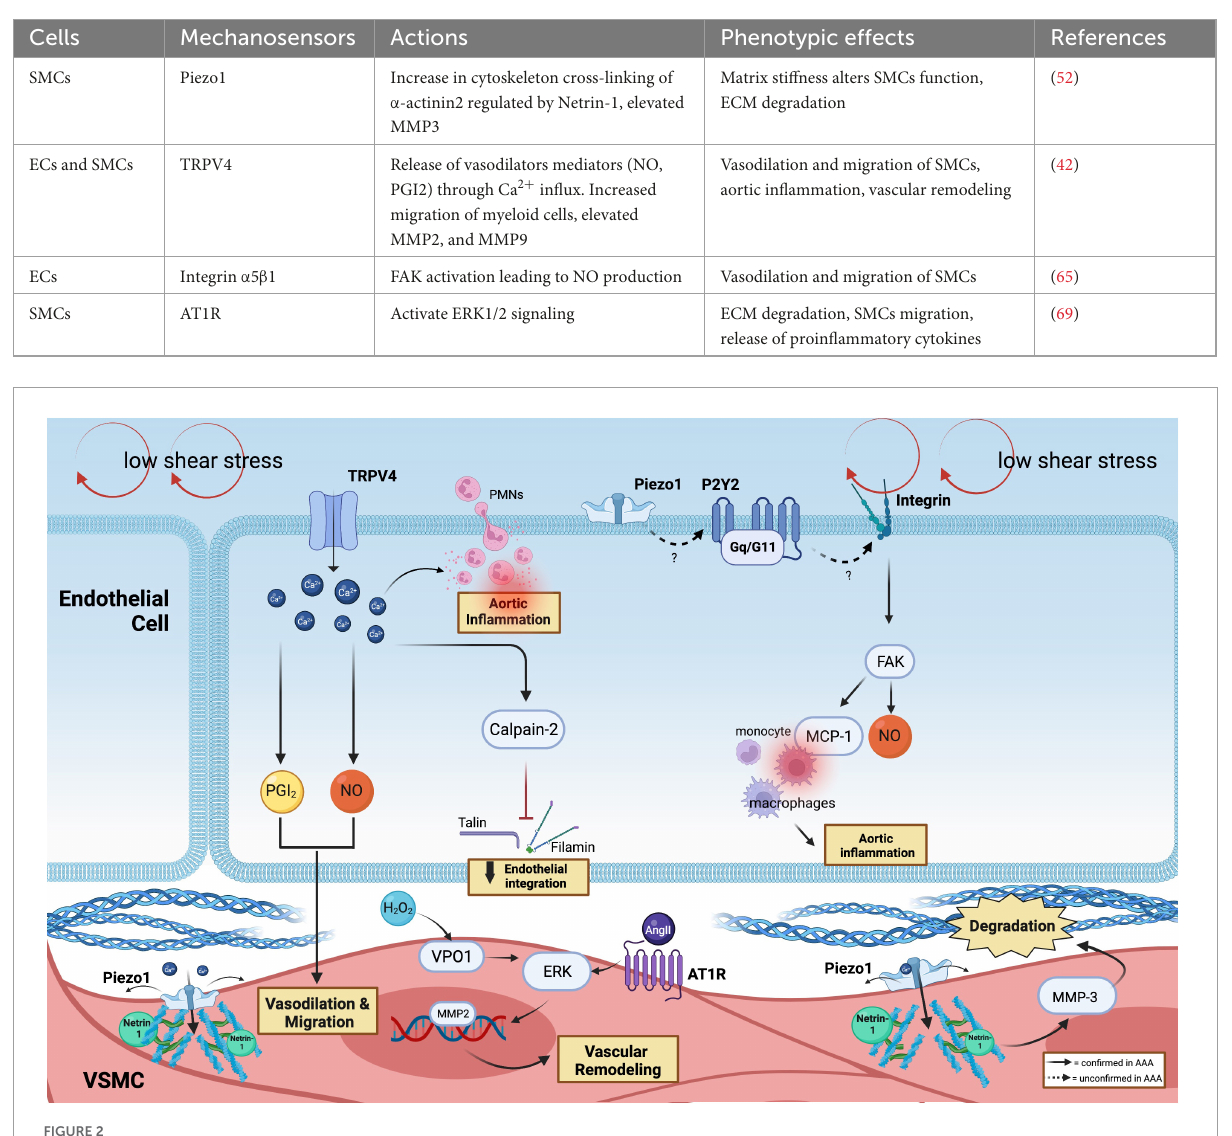
TABLE 1 Summary of mechanosensors, actions, and their phenotypic effects in AAA.